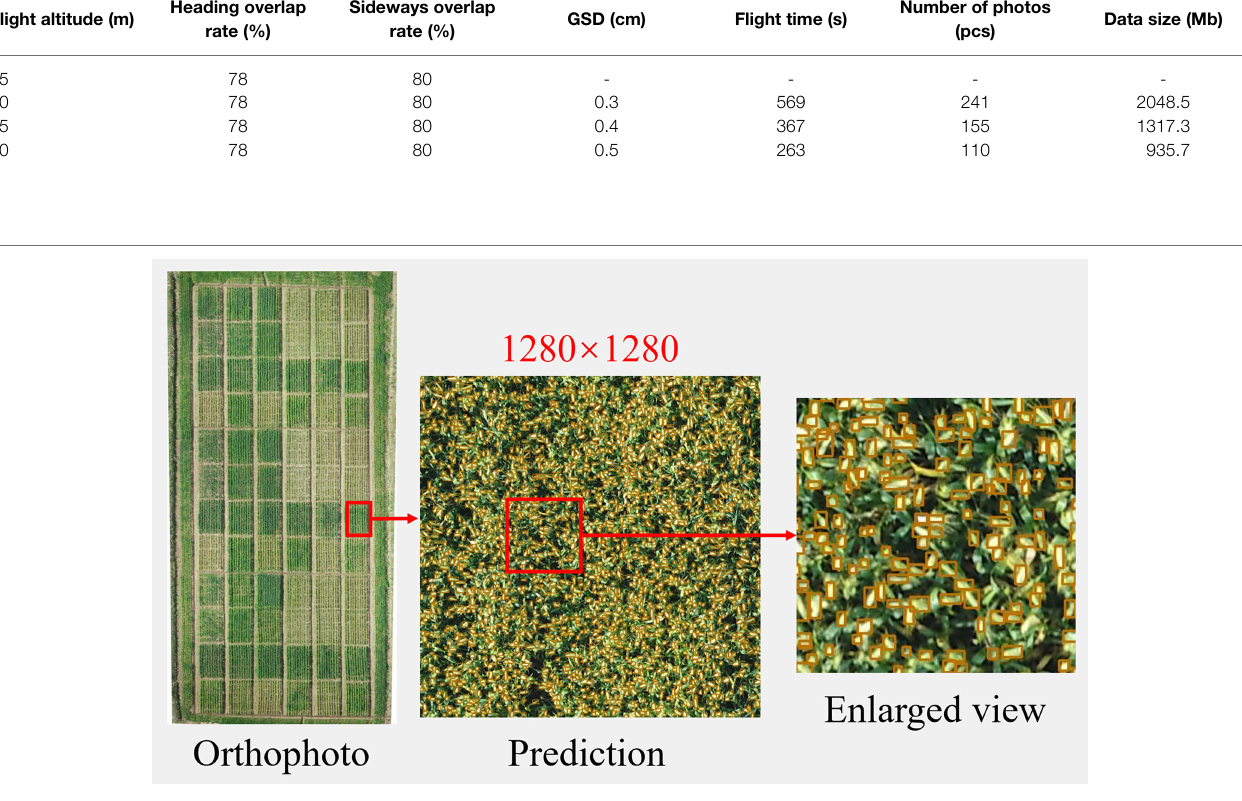
FIGURE 10 | Orthophoto cropping recognition effect.